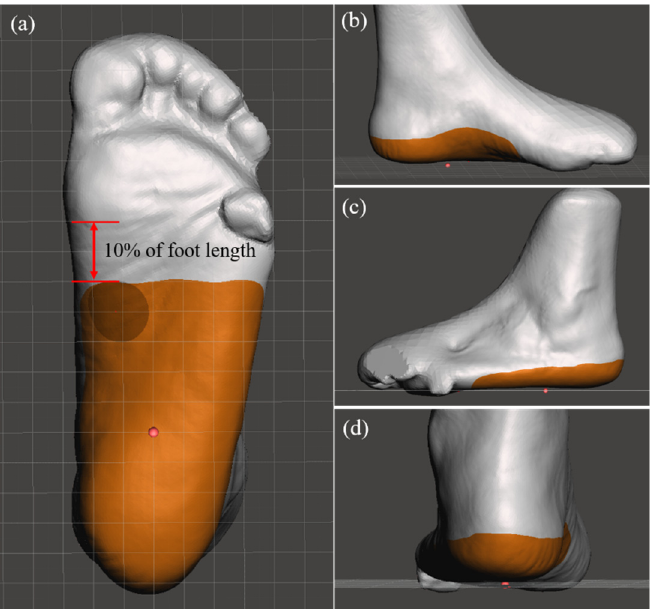
Figure 2. ( a ) The shell ends near the metatarsal heads. The distance between the shell end and the first metatarsal head is approximately 10% of foot length. ( b ) Medial shell ends near navicular tuberosity. ( c ) Lateral and ( d ) rear edges of shell.